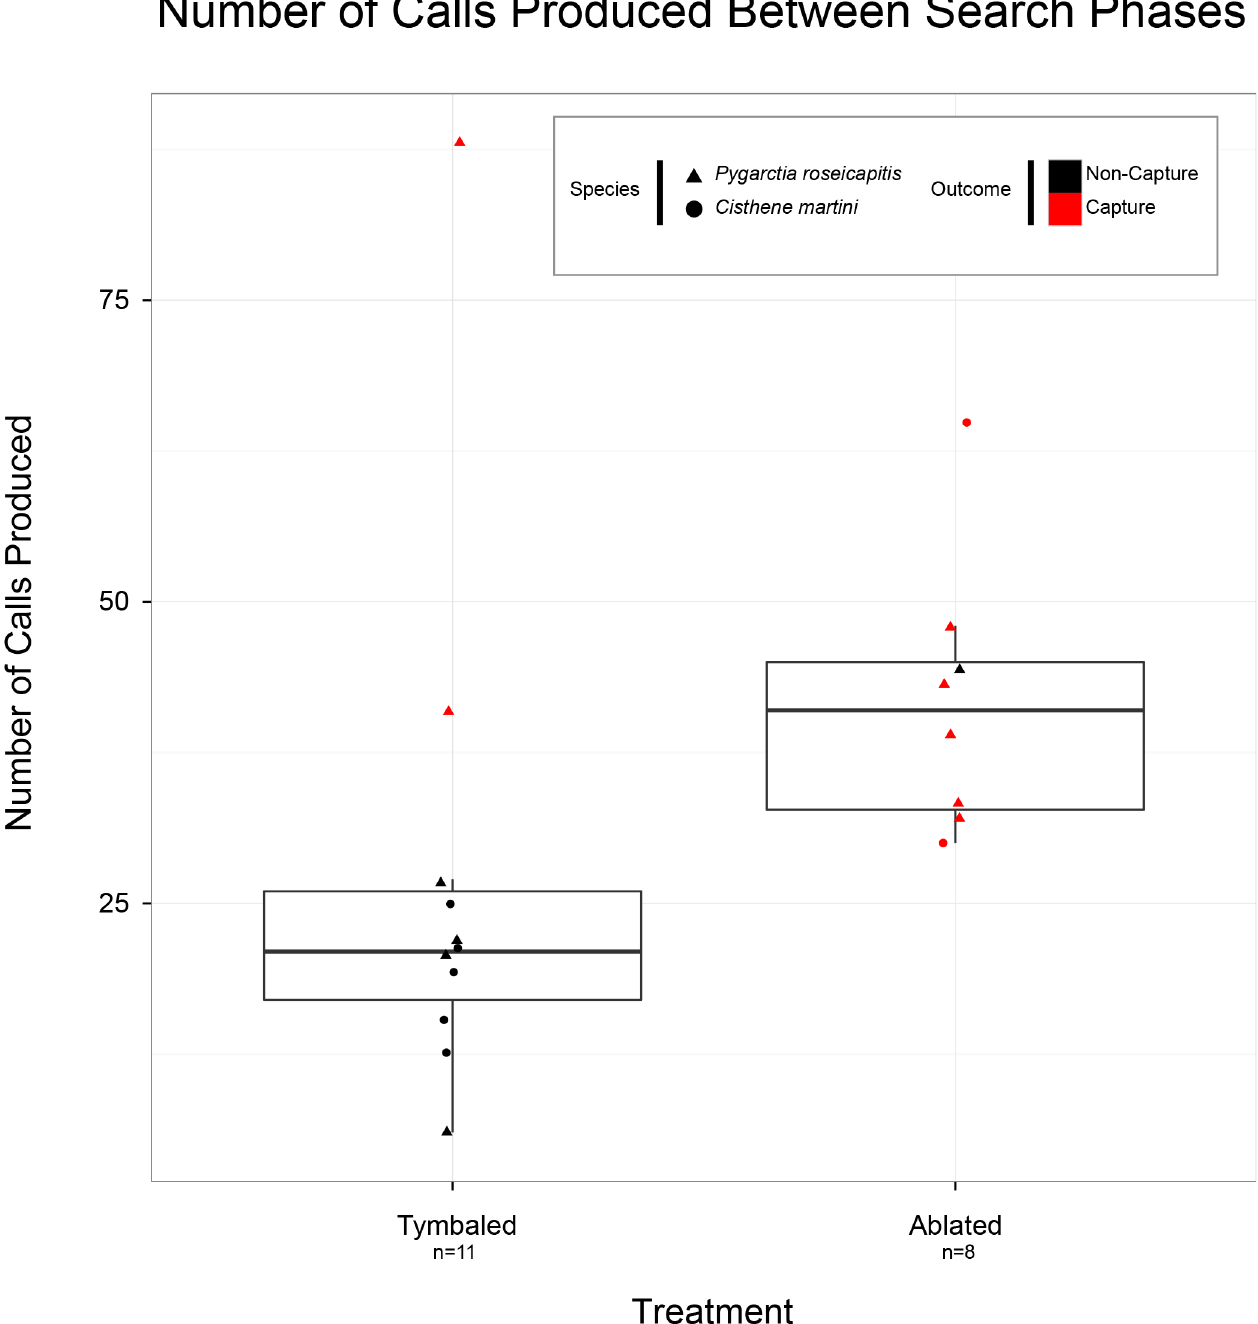
Fig 4. Number of echolocation calls bats produced between search phases for “ Tymbaled ” (T+ and S groups), sound-producing Pygarctia roseicapitis and Cisthene martini . Boxplot follows plotting conventions in Fig 3. For each interaction, moth species identity has been coded as shape and the outcome of each interaction is coded by